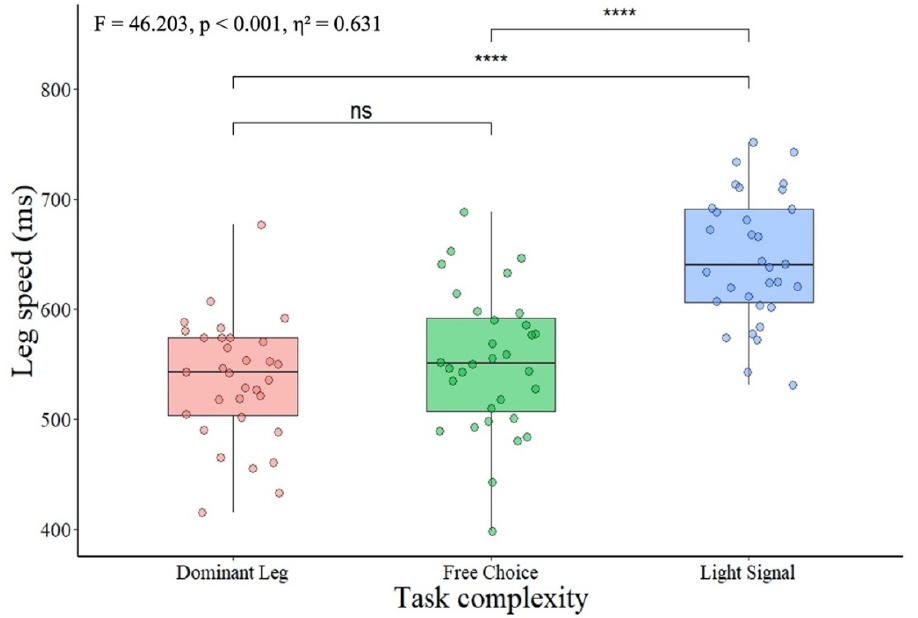
Figure 2. The Leg movement response time in tasks of different complexity. Note: ns—not significant and **** significant at p < 0.0001. Dominant hand—speed of dominant hand on light signal; dominant leg—dominant leg response time on light signal; free choice—leg response time when participants were given a free choice of either dominant or non-dominant leg; light signal—leg response time on the specific light signal. With the right leg if the signal turns red and with the left leg if the signal turns blue.